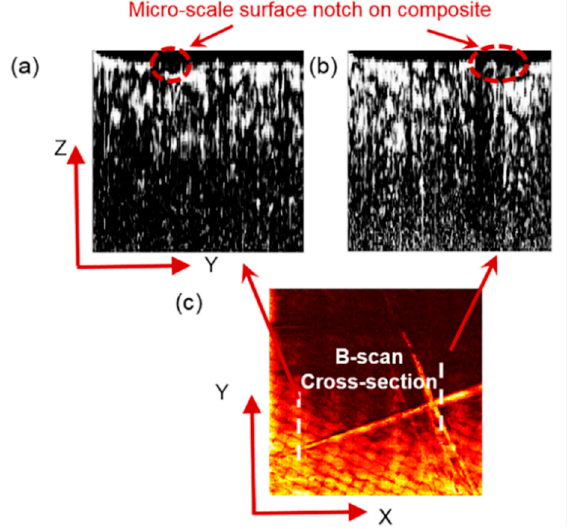
Figure 5. ( a , b ) Typical B-scan images showing the vertical cross-section of the detected notch in the composite plate, at positions: x = 1.6 and 4.1 mm, respectively (from left to right). ( c ) C-scan image showing the position of B-scan images in the X-Y plane.